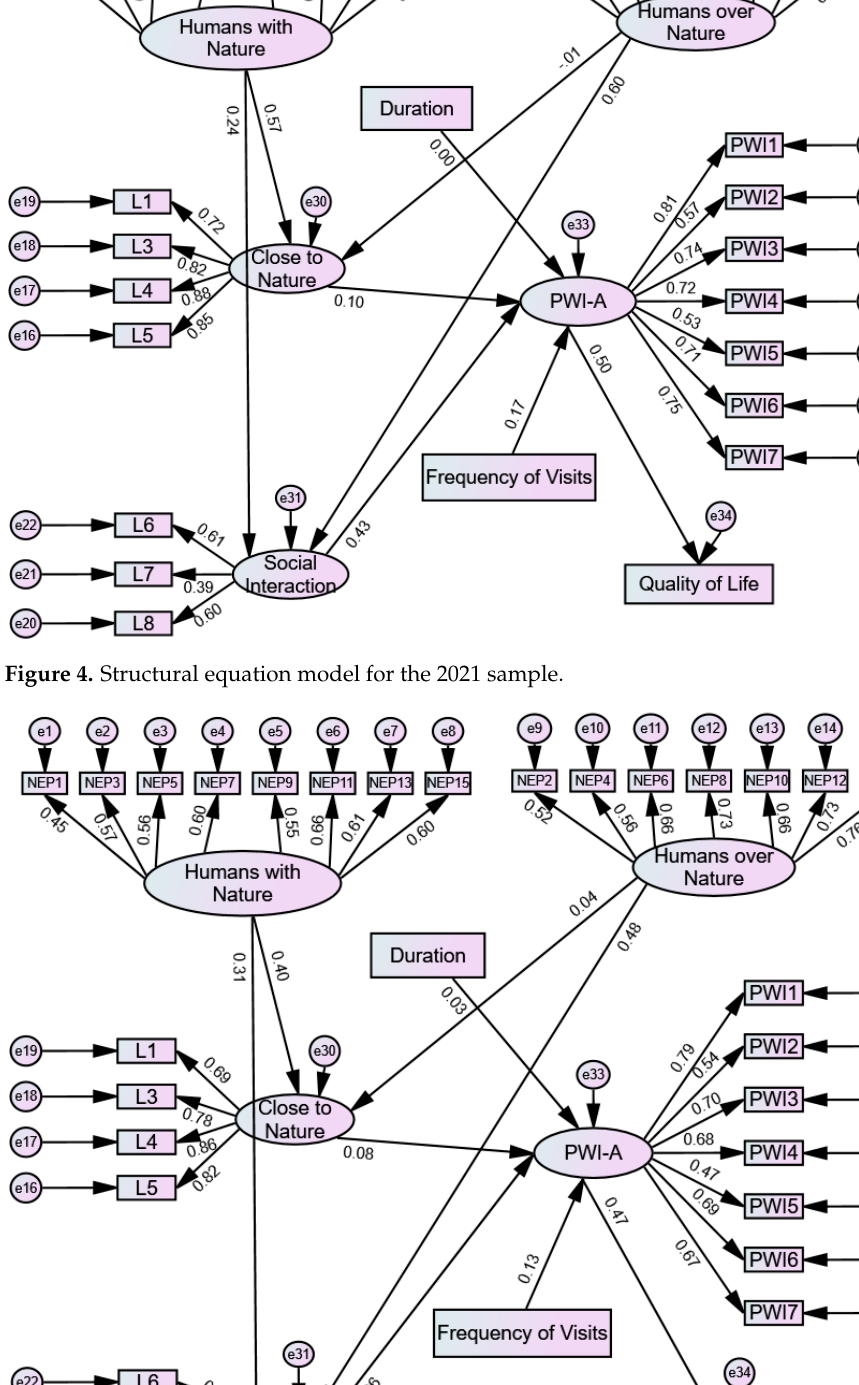
Figure 5. Structural equation model for the aggregated data (two samples combined).